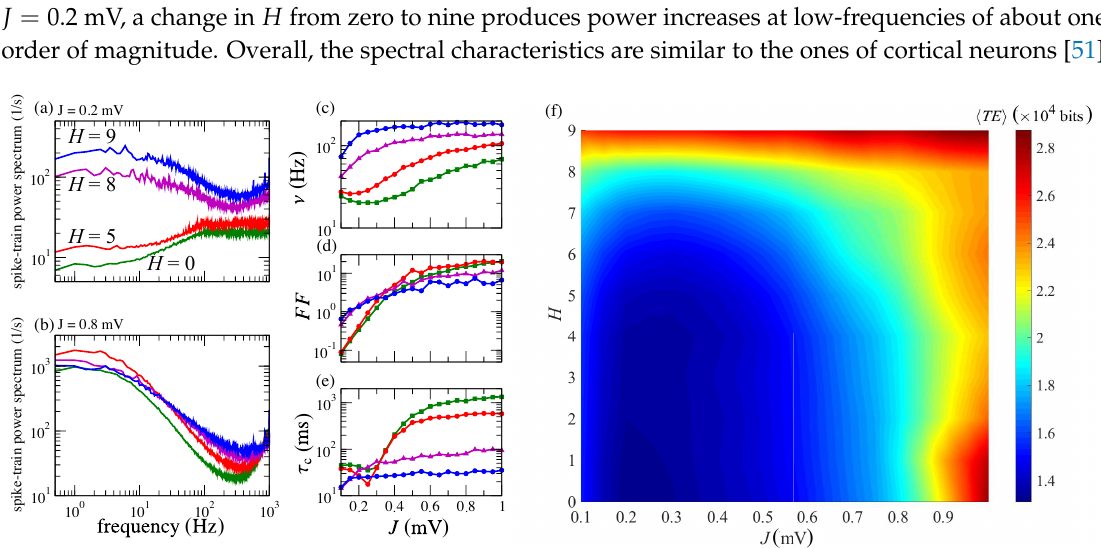
Figure 4. Increases of J and H cause amplification of slow fluctuations and enhance information transfer. ( a ) Spike-train power spectra computed for J = 0.2 mV and different values of H (indicated by different colors in the plot). ( b ) Same plot as in (a), but with J = 0.8 mV. ( c – e ) Firing rate ν , Fano factor FF , and correlation time τ c for different values of J ( H values indicated by the same colors as in (a,b)). ( f ) Average transfer entropy (computed as in Equation (11)) in a two-dimensional diagram where the abscissa represents synaptic strength J and the ordinate represents hierarchical level H . Values of (cid:104) TE (cid:105) are indicated by the color bar to the right